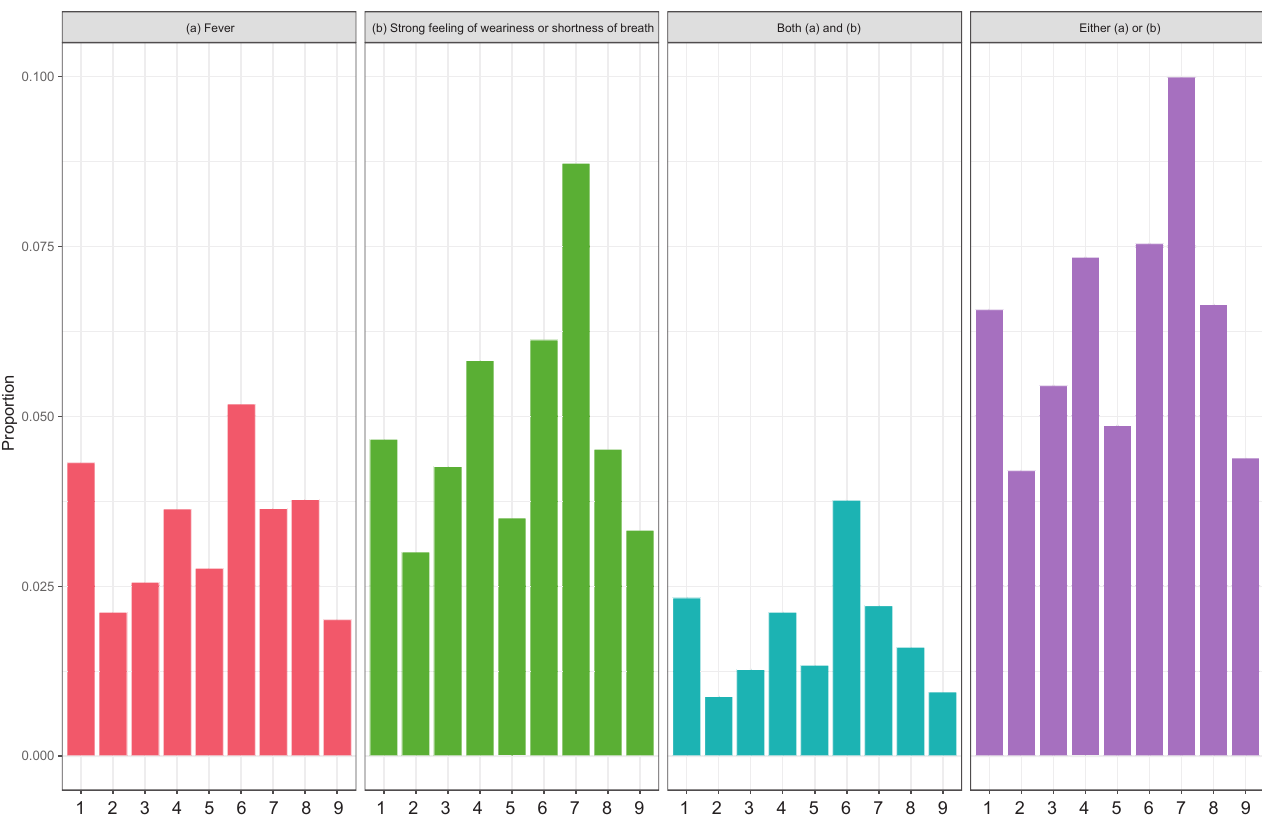
Figure 3. The proportion of participants with each non-speci fi c symptom among participants with comorbidities and pregnant. 1. Malignant tumor with anticancer drugs, 2. Malignant tumor without anticancer drugs, 3. Cardiovascular diseases, 4. Kidney diseases, 5. Diabetes mellitus, 6. In dialysis treatment, 7. Chronic obstructive pulmonary disease, 8. Treatment with immunosuppressant, 9. Pregnant.